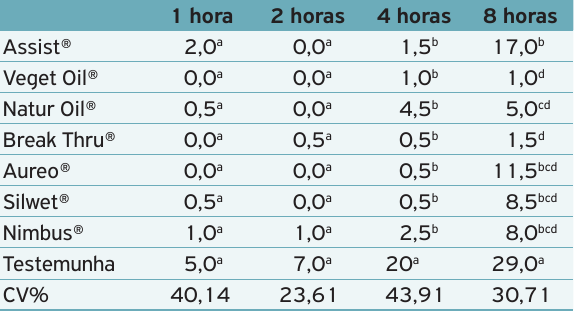
Tabela 4. Germinação (%) de uredinosporos de Puccinia kuehnii em diferentes tempos de exposição a